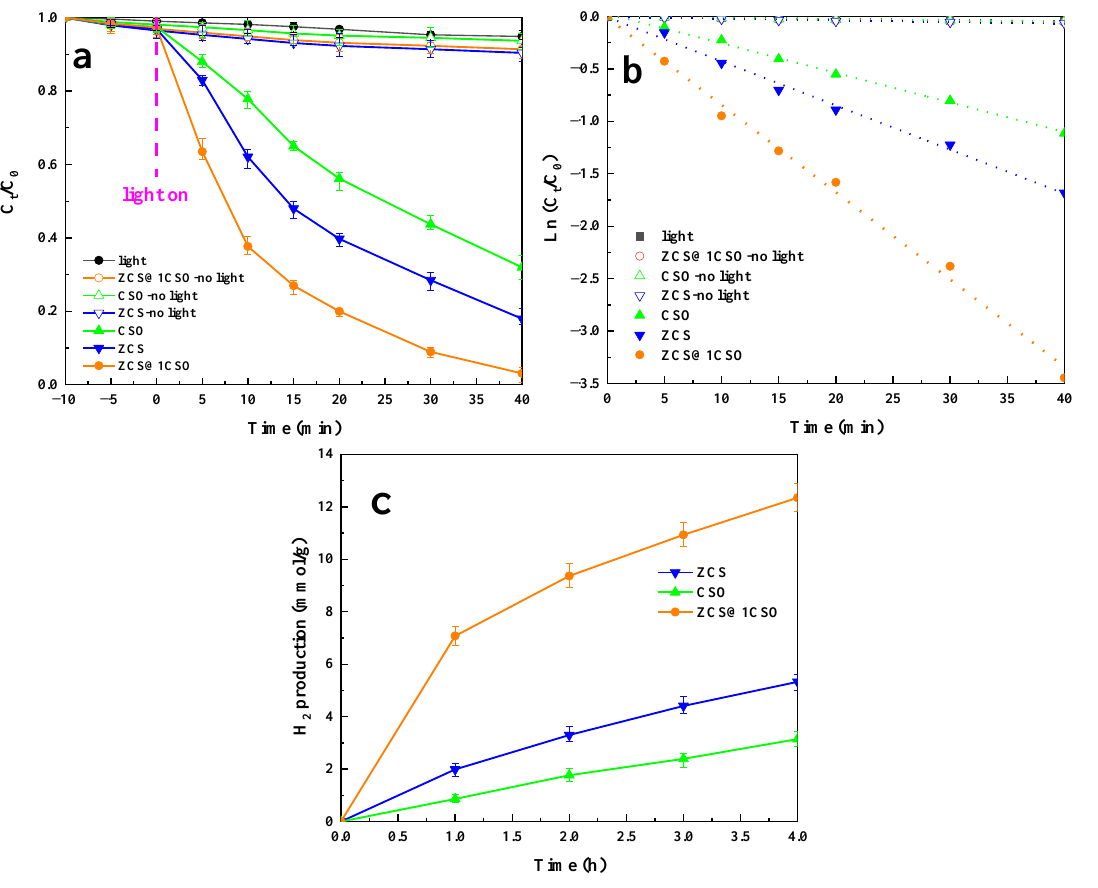
Figure 9. The MB photocatalytic degradation process ( a ), pseudo first order kinetic analysis ( b ) and H 2 production ( c ) under different photocatalytic systems.